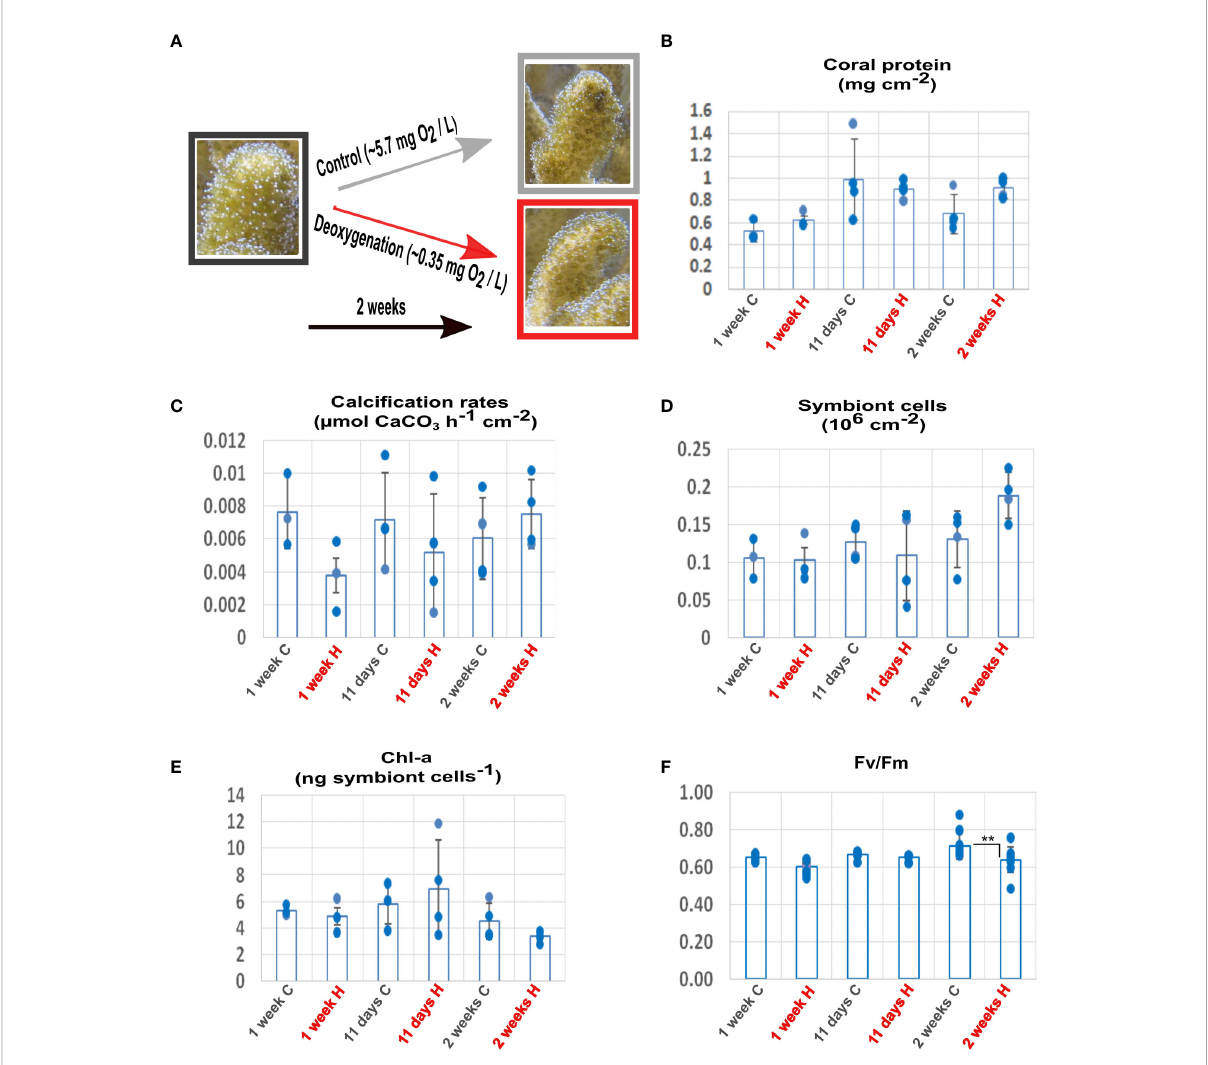
FIGURE 1 Effects of deoxygenation on the physiology of coral and symbionts. (A) Coral fragments were incubated in control (grey) or subjected to deoxygenation (red) for two weeks. For each time point, measurements were calculated for distinct fragments. (B) Protein amount. (C) Calci fi cation rates. (D) Symbiont cell counts. (E) Chlorophyll- a (chl- a ) concentration per symbiont cell. (F) Maximum (Fv/Fm) quantum yield of photosystem II. ** P < 0.01. (Data